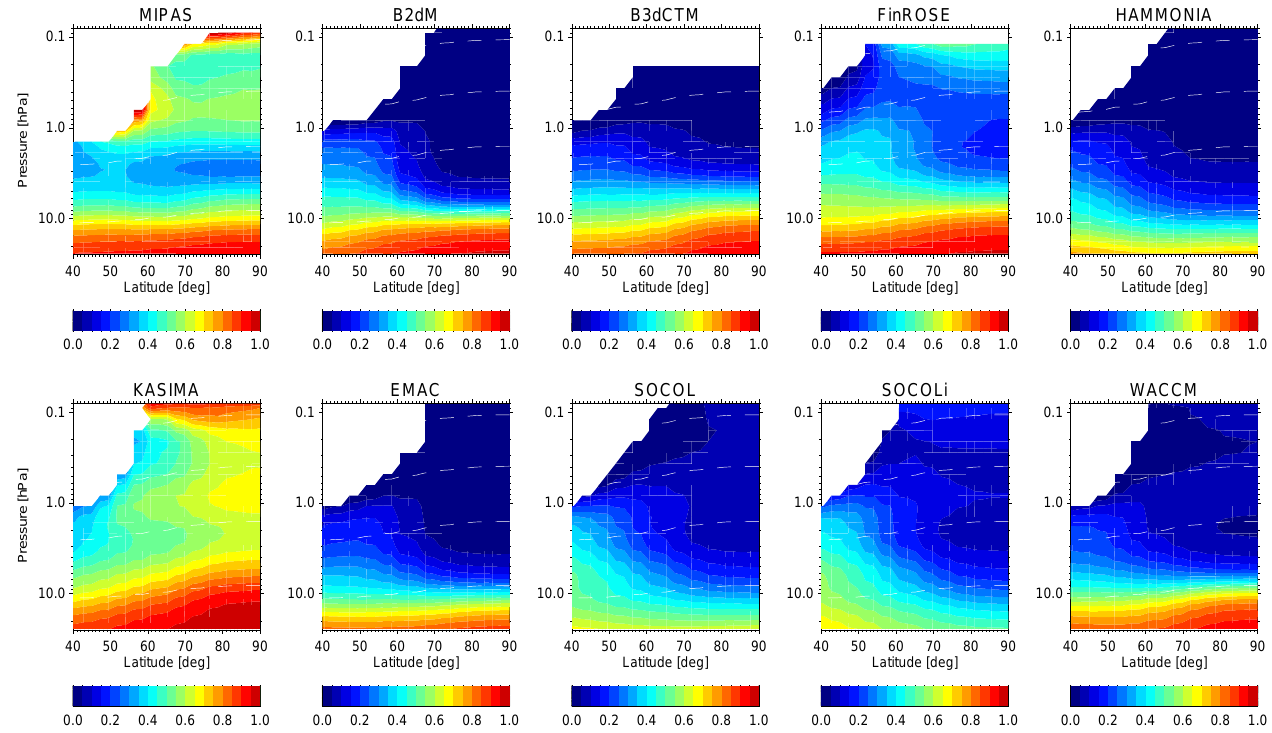
Fig. 24. Zonal mean HNO 3 /(2N 2 O 5 +HNO 3 ) ratios averaged over the period 15–30 November in MIPAS observations and model simula- tions. Regions with observed vmrs of 2N 2 O 5 +HNO 3 smaller than 0.1ppbv have been omitted. O Fig. 24. Zonal mean HNO /( 2N + HNO ) ratios averaged over the period 15–30 November in MIPAS observations and model simula- 3 2 5 3 zonal mean distributions of HNO 4 vmrs during the first four ClONO 2 enhancements up to 0.4 ppbv a few days after the O tions. Regions with observed vmrs of 2N + HNO smaller than 0.1 ppbv have been omitted. 2 5 3 proton forcing from MIPAS observations. These observa- days of the proton forcing (29 October–1 November). Model results for pre-SPE conditions (26 October) are also shown. tions are compared to the model simulations in Sect. 6.6, to- gether with observations of other chlorine species. MIPAS HNO 4 model output is not available from CAO, EMAC, HAMMONIA, and FinROSE. Polar upper stratospheric en- hancements of up to 0.18 ppbv are visible in the observa- tions on 30 October, decreasing until 1 November by about 20 %. The HNO 4 enhancements are also simulated by the models in the first days of the SPE, but are generally over- estimated. The overestimation is most pronounced in the B2dM, B3dCTM, and WACCM simulations (a factor